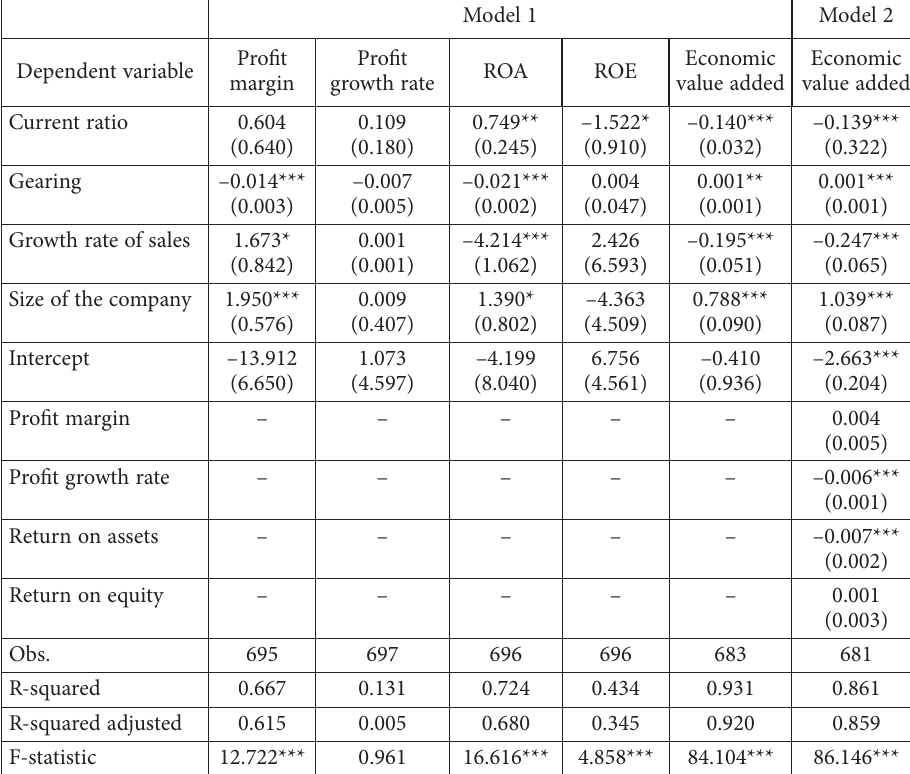
Table 4. Regression analysis results (source: authors’ own